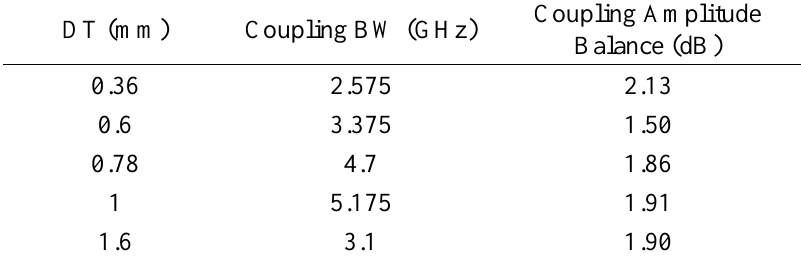
Table 2. Coupler performances vs. dielectric thickness (DT)